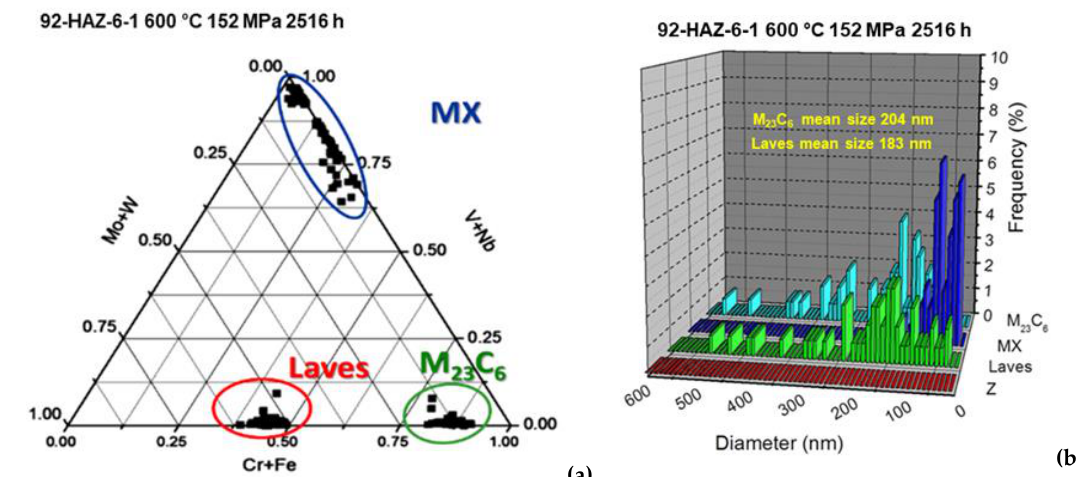
Figure 19. Subproject N°6: GR 92 HAZ CREEP failed crept cross-weld specimen 92-HAZ-6-1 600 °C 152 MPa 2516 h (sample F), ternary diagram ( a ) and size distribution ( b ) (TEM analysis).